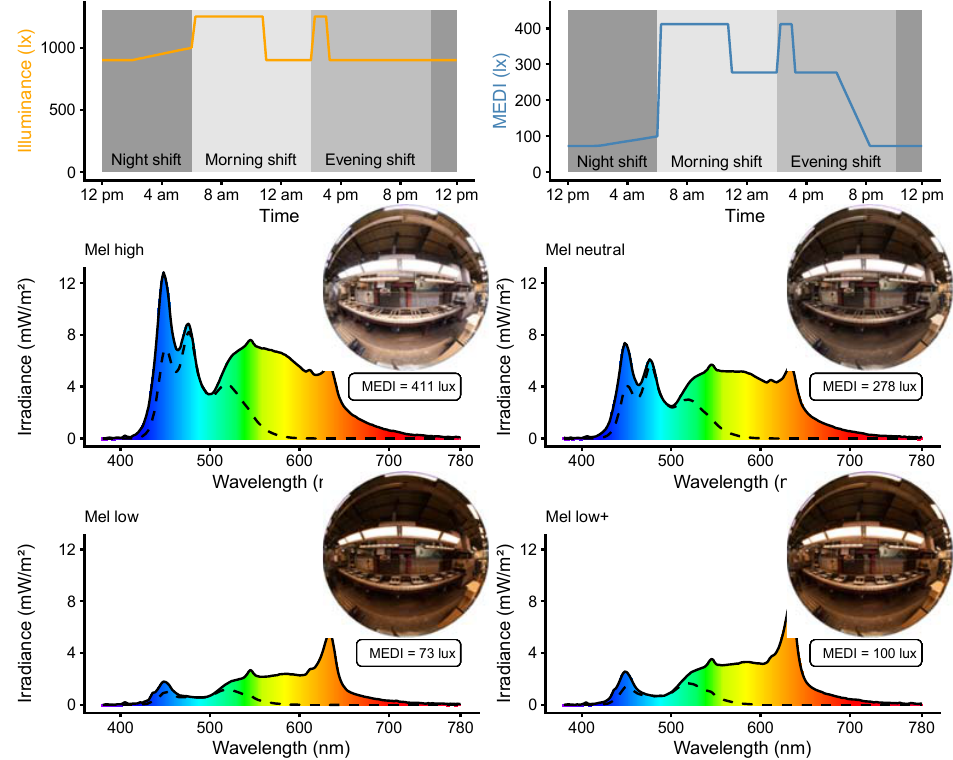
Figure 6. Measurement results and automation schematics for the new lighting system at the quality control workplaces. The top panels show the horizontal illuminance (lx, orange) and the vertical MEDI (lx, blue). The middle and bottom panels each show the spectral measurement result for one melanopic setting as explained in the main text, alongside a 180° fisheye photograph of the workspace during the light setting. The dashed curves show the raw spectrum (solid line, colored in) when multiplied with the melanopic sensitivity curve.